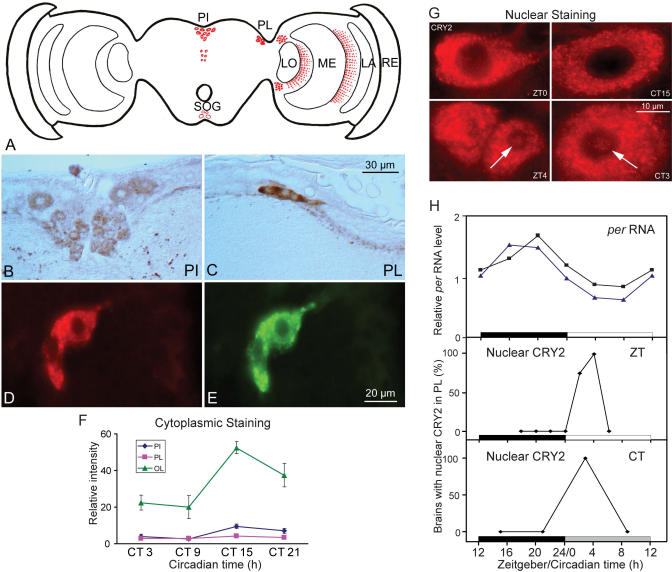
CRY2 Protein Distribution and Nuclear Localization in Monarch Brain.(A) Schematic representation of a frontal section illustrating the topology of CRY2-immunoreactive cells using antibody CRY2-R42. A similar pattern of CRY2 staining was found using CRY2-GP51 (see Figure S13).(B) CRY2 immunoreactivity in neurosecretory cells in the PI.(C) CRY2 immunoreactivity in cells in the PL.(D and E) Double-labeling immunofluorescence of CRY2 (D) and COR (E) in two cells in the PL. The other two co-localized cells were out of the plane of section.(F) Semiquantitative assessment of CRY2 immunostaining in the PI, PL, and dorsal and ventral OL on the first day in DD. Intensity values were corrected for relative cell number in each group so that the values could be compared across groups. Each point is mean ± SEM of 5–6 brains. For PI, p < 0.01, one-way ANOVA; PL, p < 0.05; OL, p < 0.01.(G) Nuclear localization of CRY2 using antibody to CRY2-R42. CRY2 staining in PL at ZT 0, top left; ZT 4, bottom left; CT 15, top right; and CT 3, bottom right. DAPI counterstaining was used to define the nucleus (not shown). CRY2 staining was not found in the nucleus at ZT 0 or CT 15, but it was found in the nucleus in PL at ZT 4 and CT 3 (arrows).(H) Comparison of per RNA levels in brain with temporal patterns of CRY2 nuclear staining in PL. Upper, per RNA levels for two sets of dissected brains without photoreceptors (black and blue lines) collected at 4-h intervals over 24 h in LD. Middle, nuclear CRY2 staining in PL at seven ZT times plotted as % of brains examined (n = 4–5 brains at each time point). Lower, nuclear CRY2 staining in the PL at four time points over the circadian cycle plotted as percent of brains examined (n = 4–5 brains at each time point).